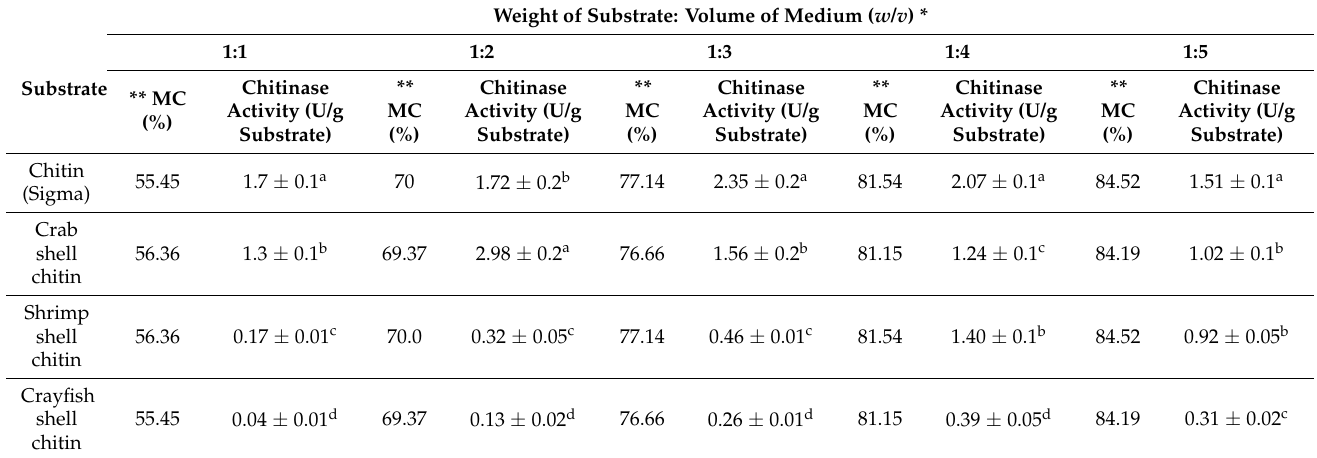
Table 1. Effect of moisture content (MC) and shellfish waste as a substrate medium ratio on the production of chitinase on solid state fermentation technique by T. funiculosus strain CBS 129594. Weight of Substrate: Volume of Medium ( w / v ) *